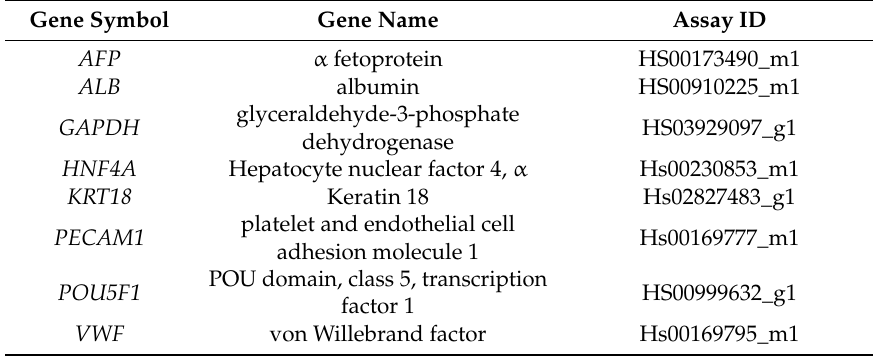
Table 3. Applied Biosystems TaqMan Gene Expression Assays ® . Gene